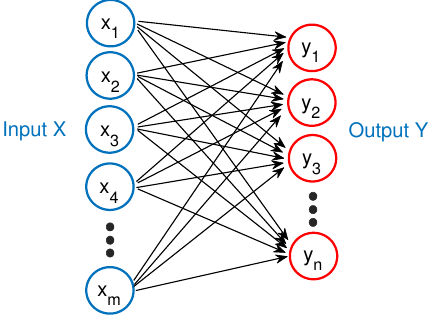
Figure 3. The two-layer NN structure utilized in this